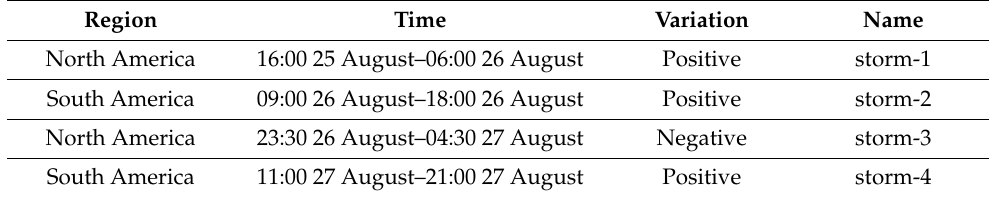
Table 1. List of four ionospheric storms.